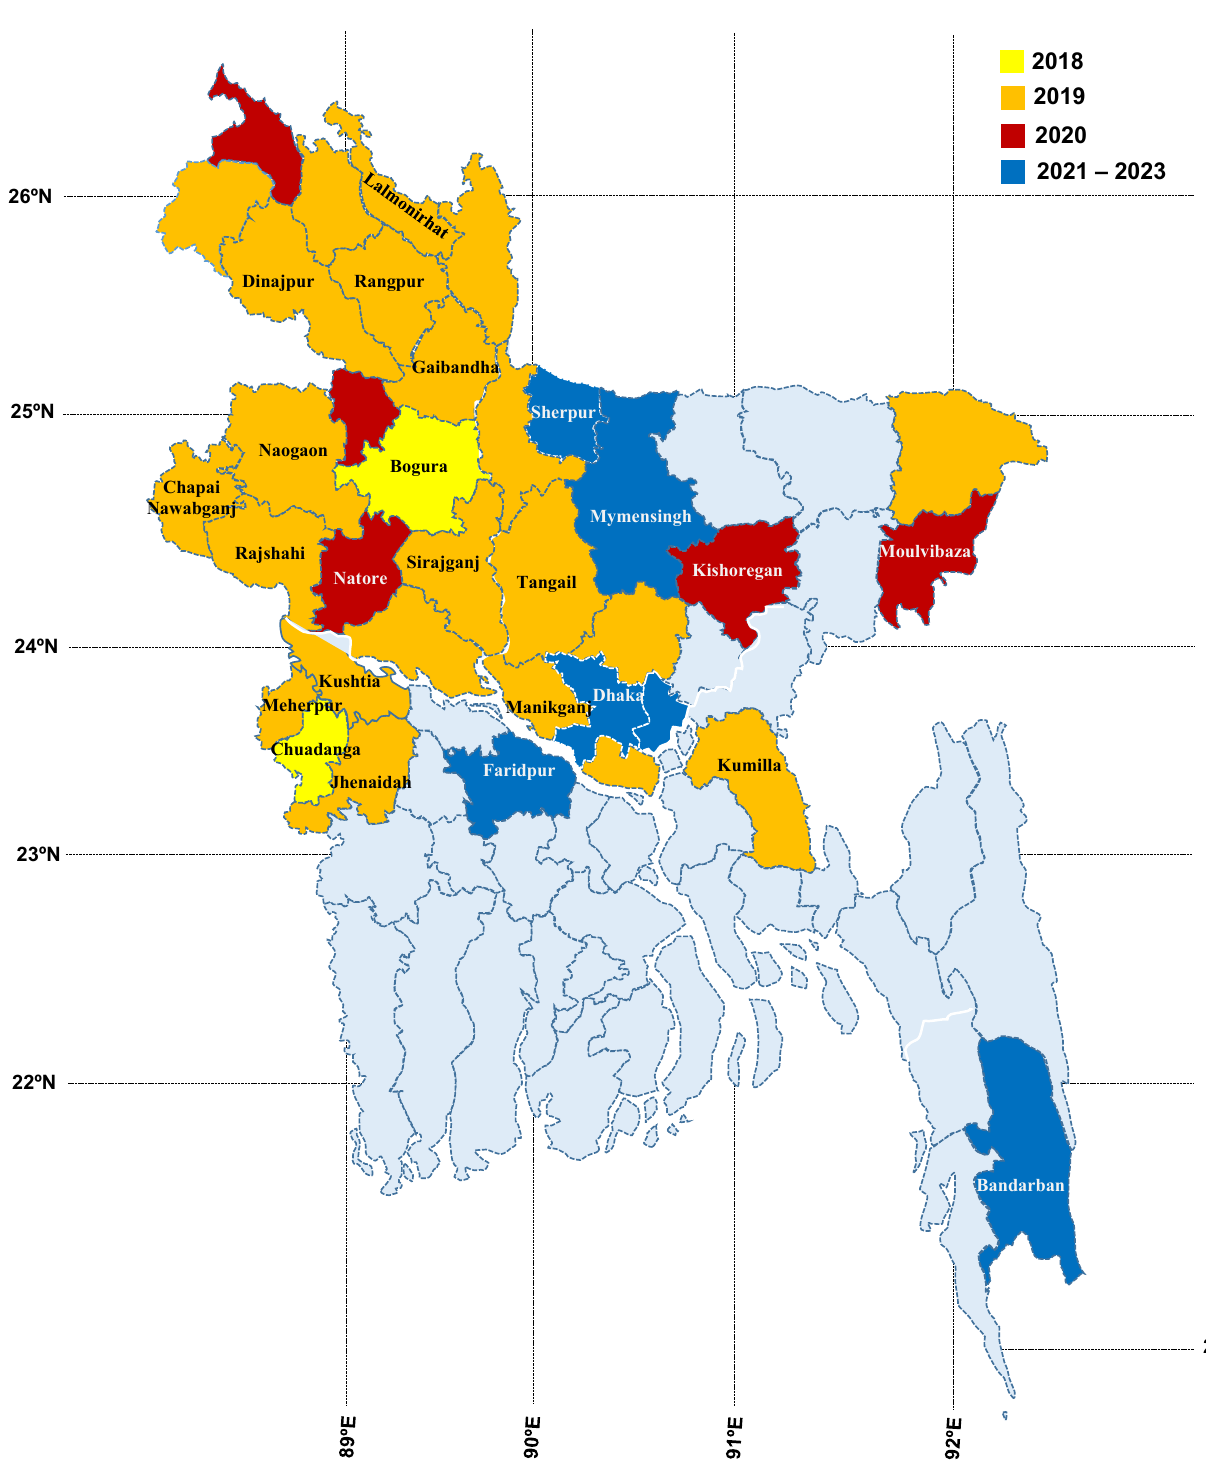
Figure 4. Distribution of fall armyworm from 2018 to 2023 in Bangladesh (different shades indicate the invasion in areas reported in the years). Districts mentioned in the map are where monitoring of fall armyworm was conducted using pheromone traps.